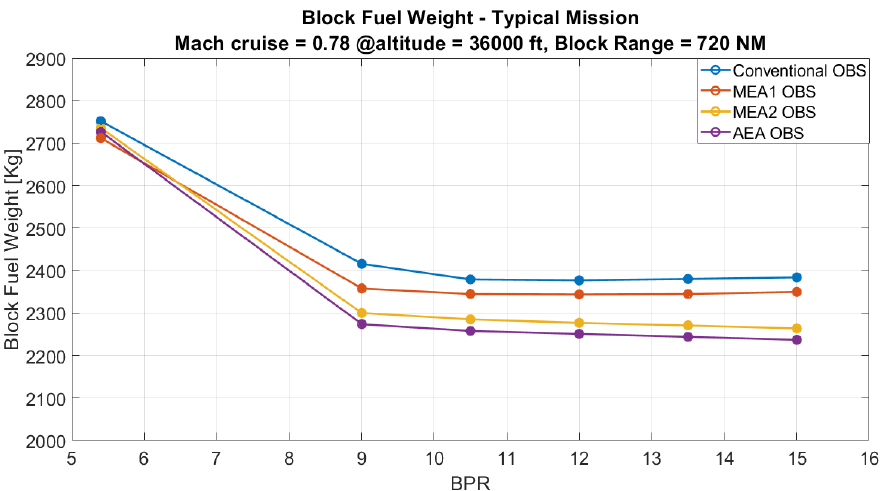
Figure 9. The trend of block fuel consumed during a typical mission by a different system solution obtained through the execution of DOE.